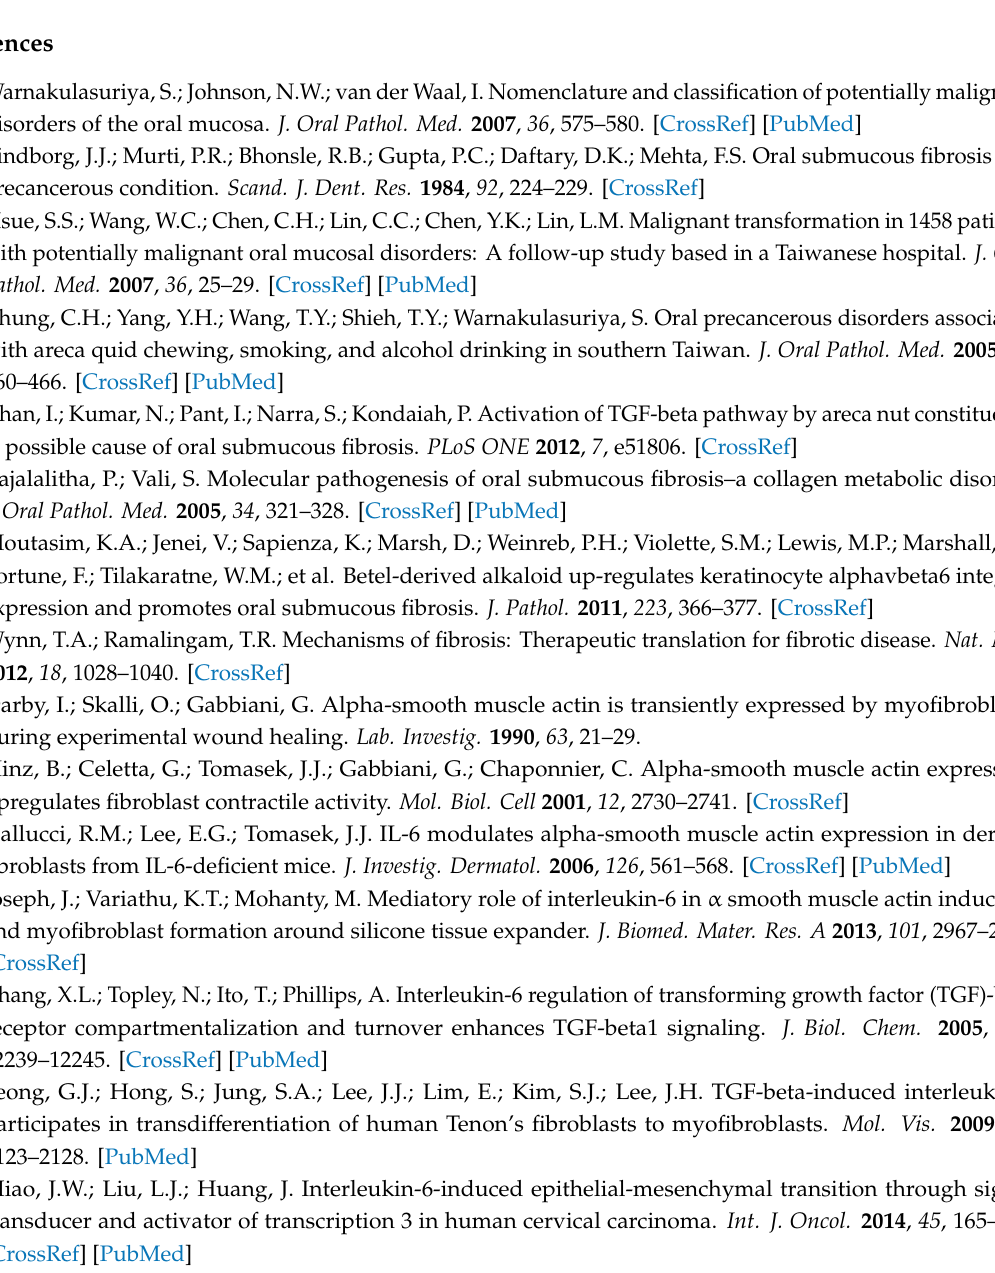
Figure S1: Original immunoblotting data for Figure 1E, Figure S2: Original immunoblotting data for Figure 2B, Figure S3: Original immunoblotting data for Figure 3A, Figure S4: Original immunoblotting data for Figure 3A, Figure S5: Original immunoblotting data for Figure 4A, Figure S6: Original immunoblotting data for Figure 4A, Figure S7: Original immunoblotting data for Figure 5B, Figure S8: Original immunoblotting data for Figure 5B, Figure S9: Original immunoblotting data for Figure 5B, Figure S10: Original immunoblotting data for Figure 5B, Figure S11: Original immunoblotting data for Figure 5B, Figure S12: Original immunoblotting data for Figure 6A, Figure S13: Original immunoblotting data for Figure 6A, Figure S14: Original immunoblotting data for Figure